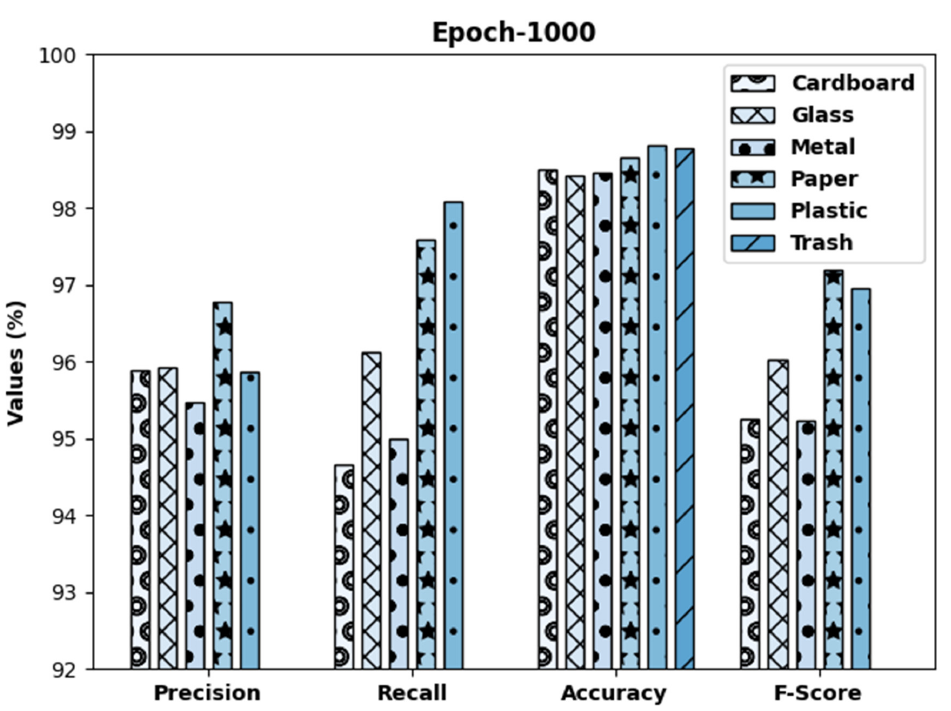
Figure 6. Result analysis of DLSODC ‐ GWM technique under 1000 epochs.